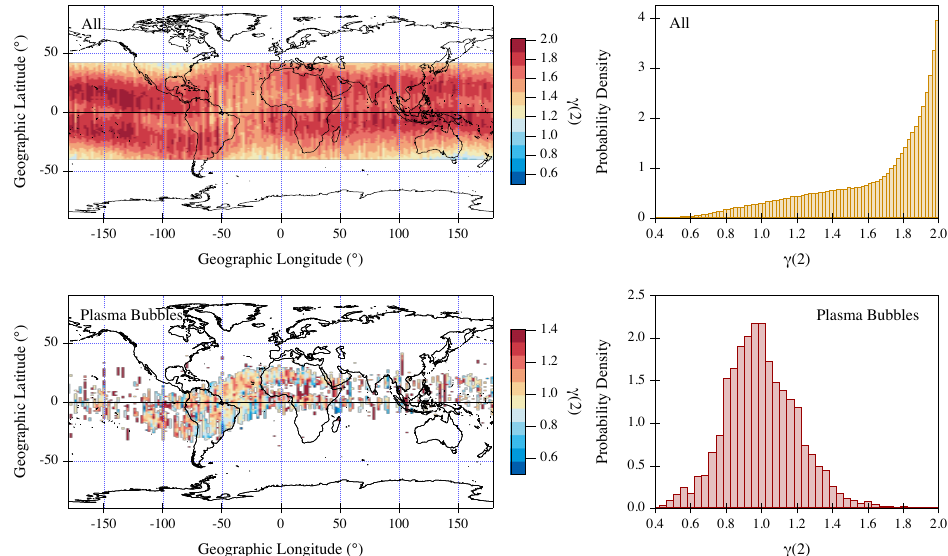
Figure 2. ( Top ): γ ( 2 ) values associated with electron density data selected according to the following conditions: 18:00-24:00 LT, ± 40 ◦ geographic latitude, Kp ≤ 3 in the latitude–longitude plane ( left ) and corresponding probability density ( right ). ( Bottom ): γ ( 2 ) values for electron density data associated with plasma bubbles in the latitude–longitude plane ( left ) and corresponding probability density ( right